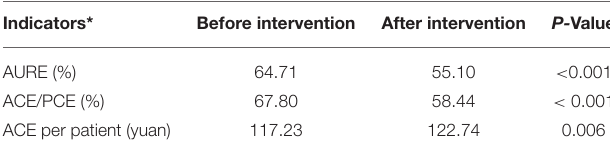
TABLE 5 | Overall changes of three indicators representing antibiotic use in emergency